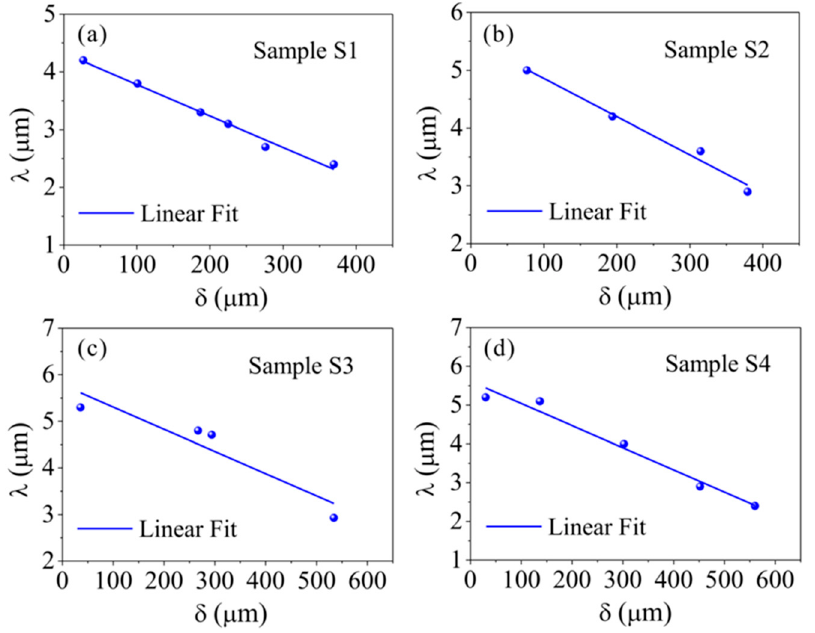
Figure 5. Local shear offset ( λ ) as a function of the distance from the origin site of shear band ( δ ) for shear bands from four samples (labeled as S1–S4) under cyclic compression [45]: ( a ) Sample S1; ( b ) Sample S2; ( c ) Sample S3; ( d ) Sample S4.